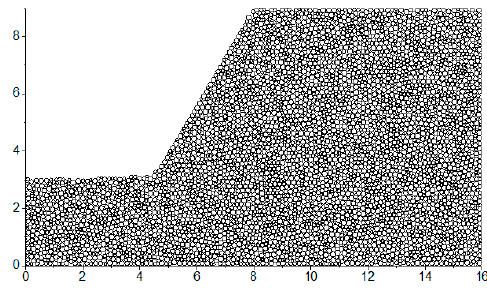
Figure 9. The granular slope example.